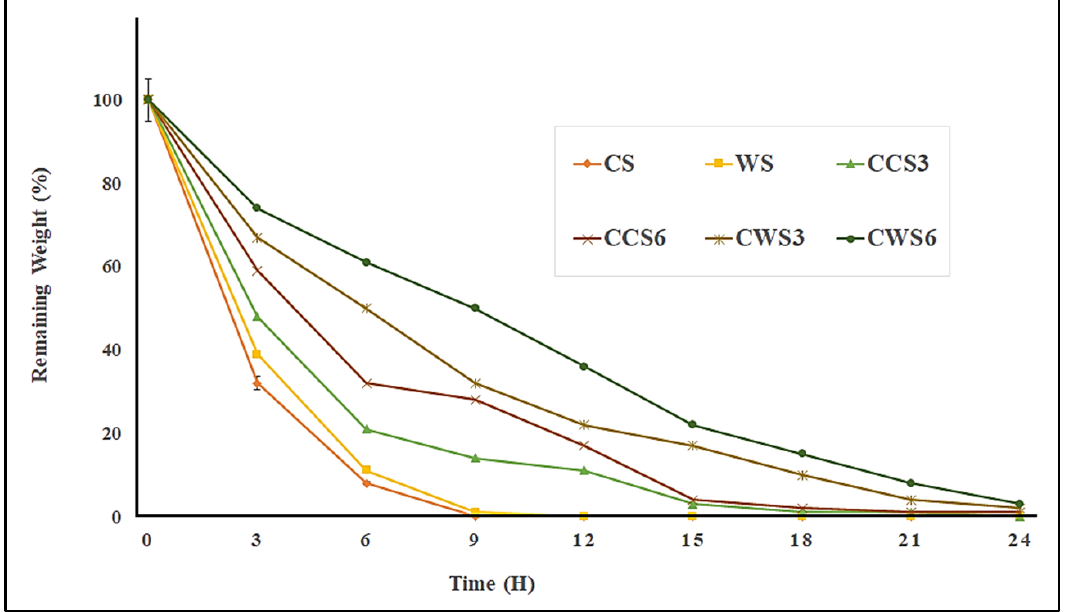
Figure 5. In vitro degradation properties of hydrogel samples in phosphate buffer solutions at 37 °C and pH 7.